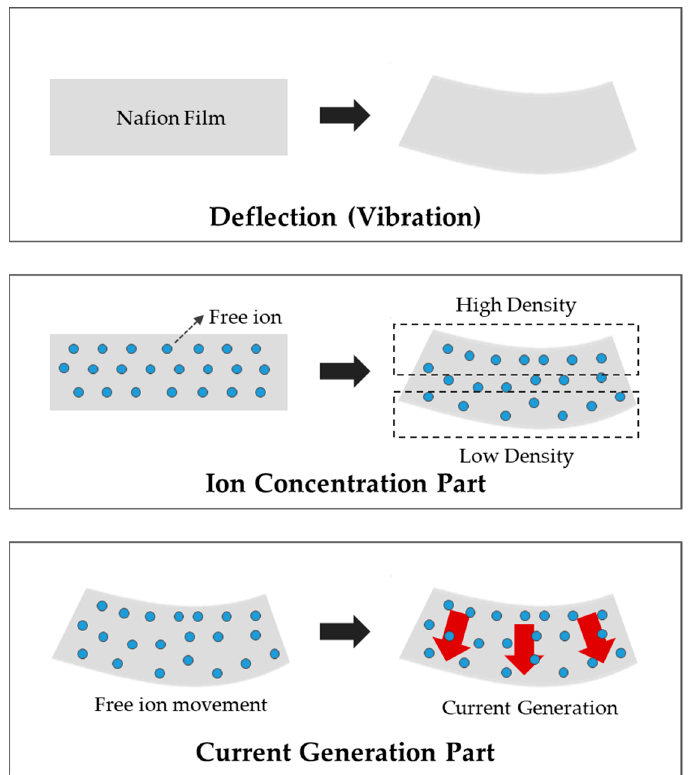
Actuators 2020 , 9 , x FOR PEER REVIEW Figure 6. Schematic diagram of the composition of harvester equipment. Figure 6. Schematic diagram of the composition of harvester equipment.